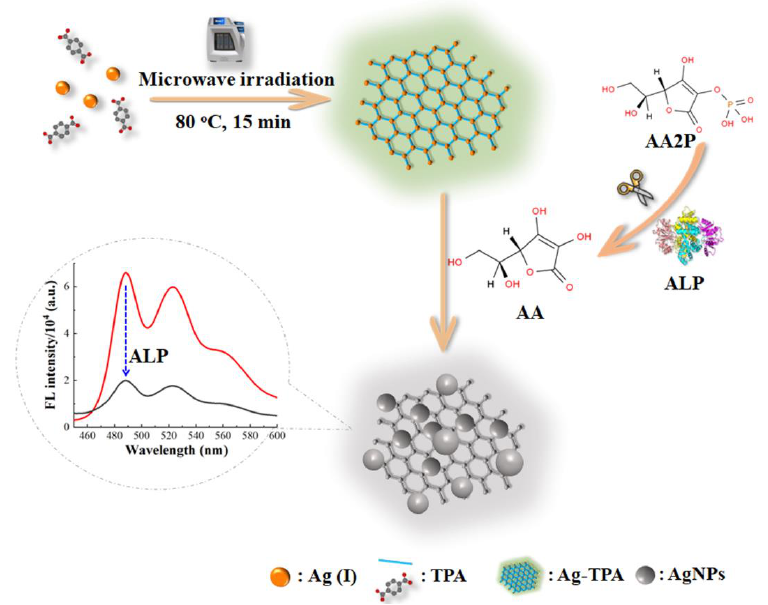
Scheme 1. Schematic representation of ultrarapid microwave-assisted synthesis of fluorescent Ag- TPA CPNs and their application for the fluorescent “turn-off” sensing of ALP